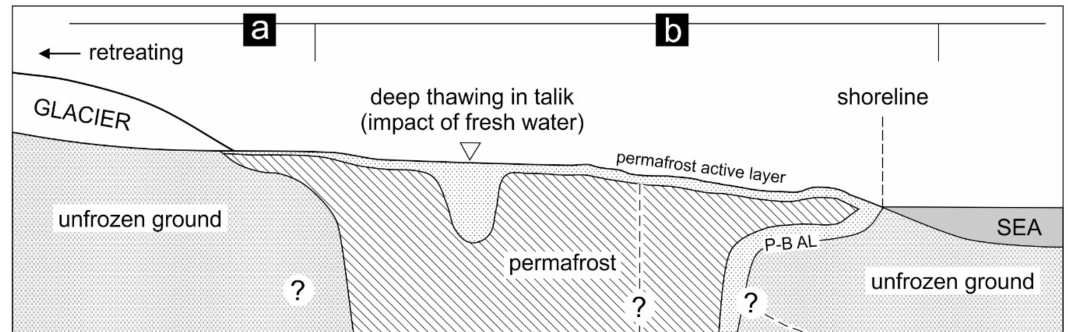
Figure 6. A conceptual model of the permafrost between the sea coast and the glacier front: ( a ) based on glaciological research [36,37], ( b ) based on geophysical imaging; P-B AL—permafrost-base active layer (?); vertical dashed line drawn in permafrost to distinguish ground with di ff erent apparent resistivity (reference to the ERT measured apparent resistivity pseudosection in Figure